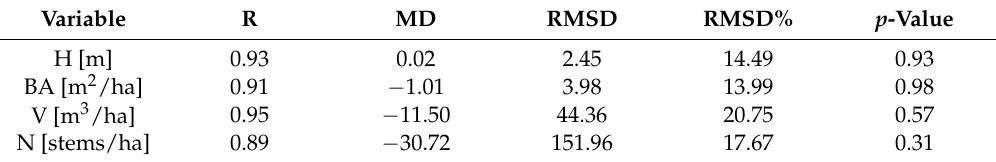
Table 6. Comparison of stand attributes projected to T2 based on approach 1 and approach